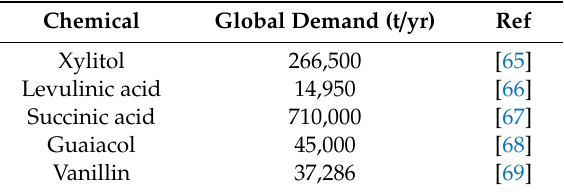
Table 2. The global demand for each